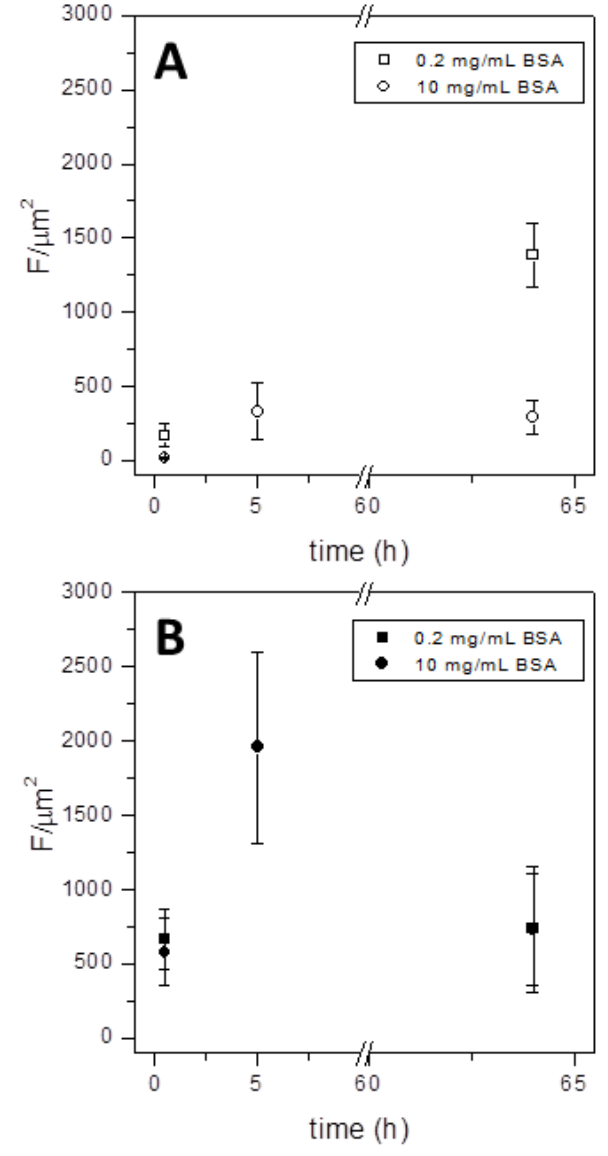
Figure 14. BSA-TAMRA adsorption on the aluminum side ( A ) and the silicon side ( B ) of microgrippers. Adsorption is shown as fluorescence intensity per area unit. Two different concentrations of BSA were incubated, i.e., 0.2 mg/mL (squares) and 10 mg /mL (circles), for 30 min, 5 h or 64 h at room